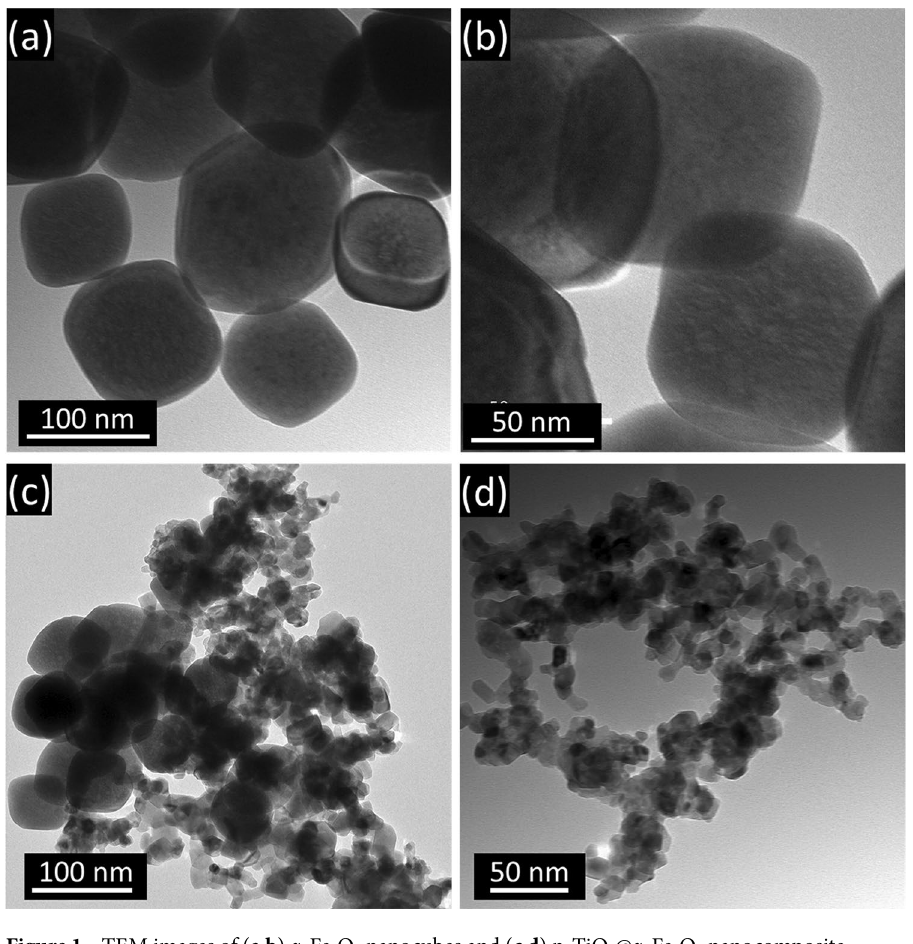
Figure 1. TEM images of ( a , b ) α-Fe 2 O 3 nanocubes and ( c , d ) n-TiO 2 @α-Fe 2 O 3 nanocomposite.